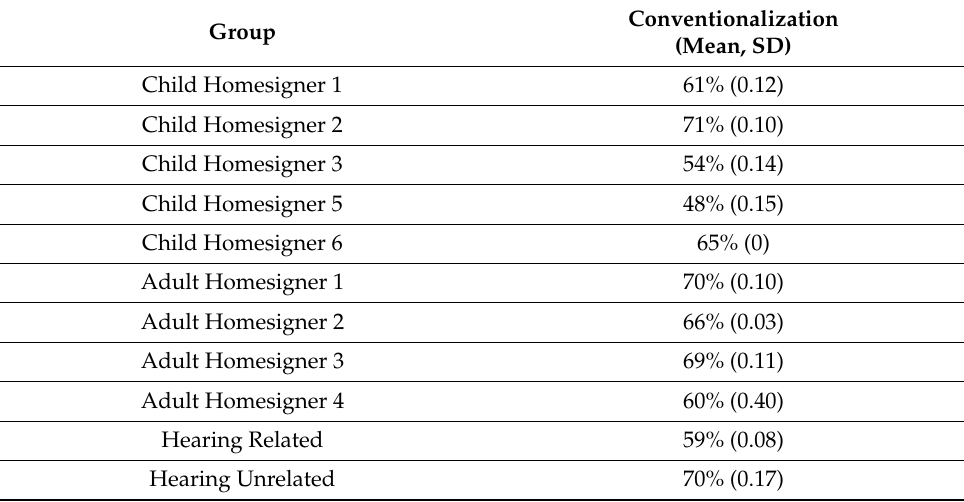
Table 5. Average conventionalization of all family members for each group. Group